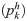
Example of how a hypothesis is corrected on a simple isochronous beat.From bottom to top: (ri) the rhythmic passage events with the onsets originating our tactus hypothesis marked differently, (pkh) the projection of the hypothesis, and (pkh+Δh) the projection of the corrected hypothesis.